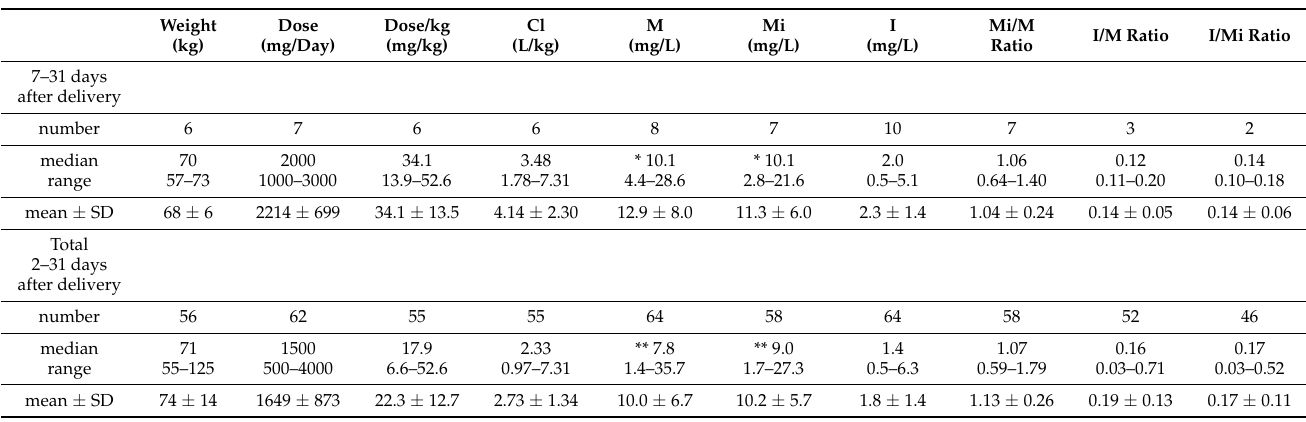
ratio which reached approximately a sixth of the value (mean 0.19 ± 0.13) similarly as the mean of infant serum/milk concentrations ratio (mean 0.17 ± 0.11), see Table 4. Table 4. Dosage, maternal apparent oral clearance (Cl), maternal (M) serum, milk (Mi), and infant (I) serum levetiracetam concentrations and their ratio 7–31 days after delivery and 2–31 days after delivery altogether. Weight Dose Dose/kg Cl M Mi I Mi/M (kg) (mg/Day) (mg/kg) (L/kg) (mg/L) (mg/L) (mg/L) Ratio I/M Ratio I/Mi Ratio